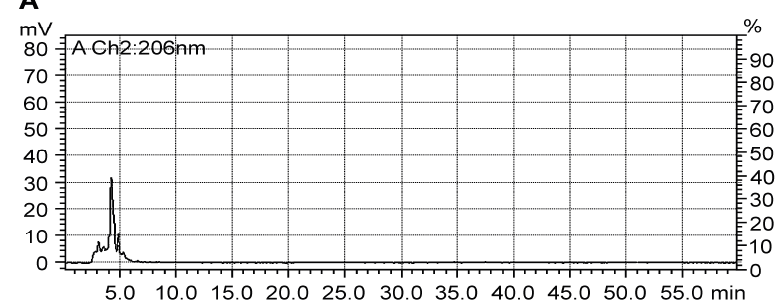
Figure 3. Representative HPLC Chromatograms of Blank ( A ), Standards ( B ) and Rhizoma Musae Samples Collected from Guiyang ( C